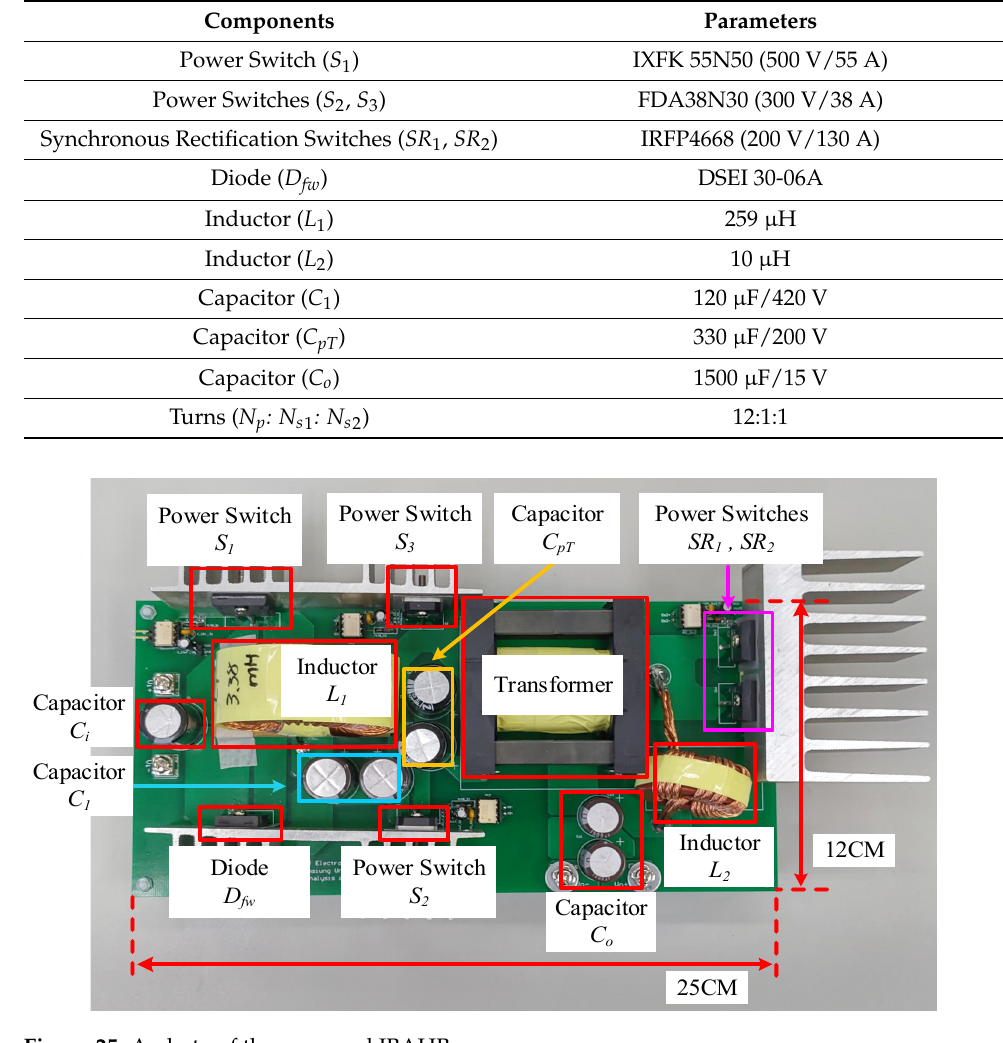
Figure 25. A photo of the proposed IBAHB.